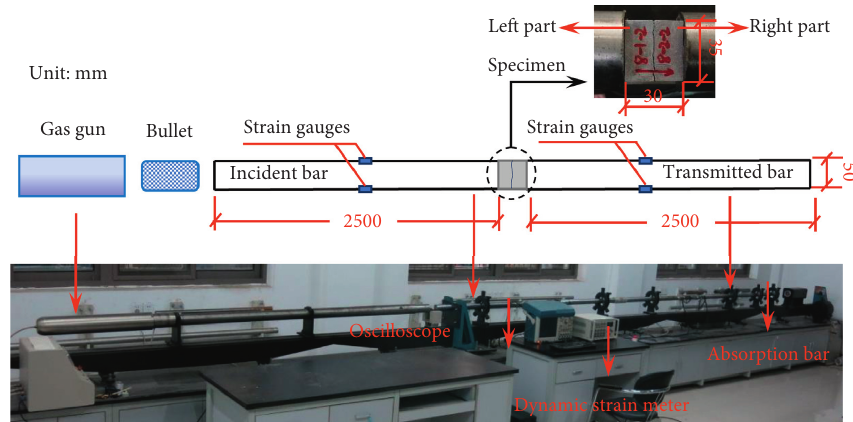
Figure 1: The split Hopkinson pressure bar (SHPB) system.